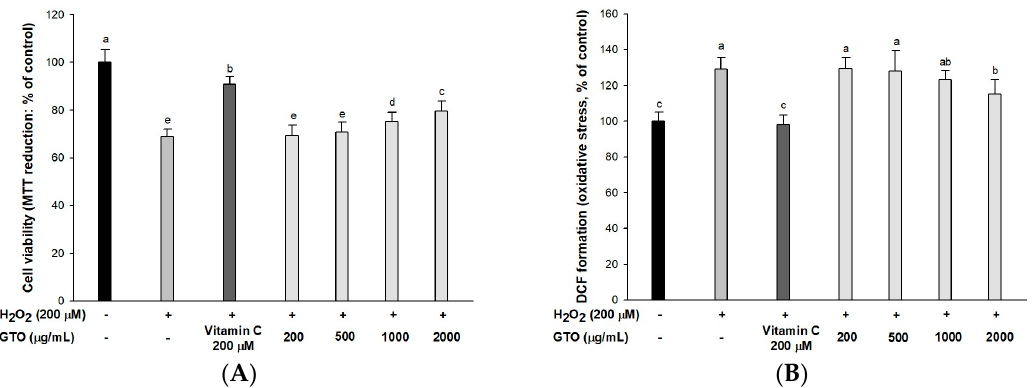
Figure 2. Neuroprotective effect of green tea seed oil (GOT) in PC12 cells. ( A ) Cell viability; ( B ) cellular oxidative stress. Results shown are mean ± SD ( n = 3). Data were statistically represented at p < 0.05, and different lowercase letters indicate statistical significance.